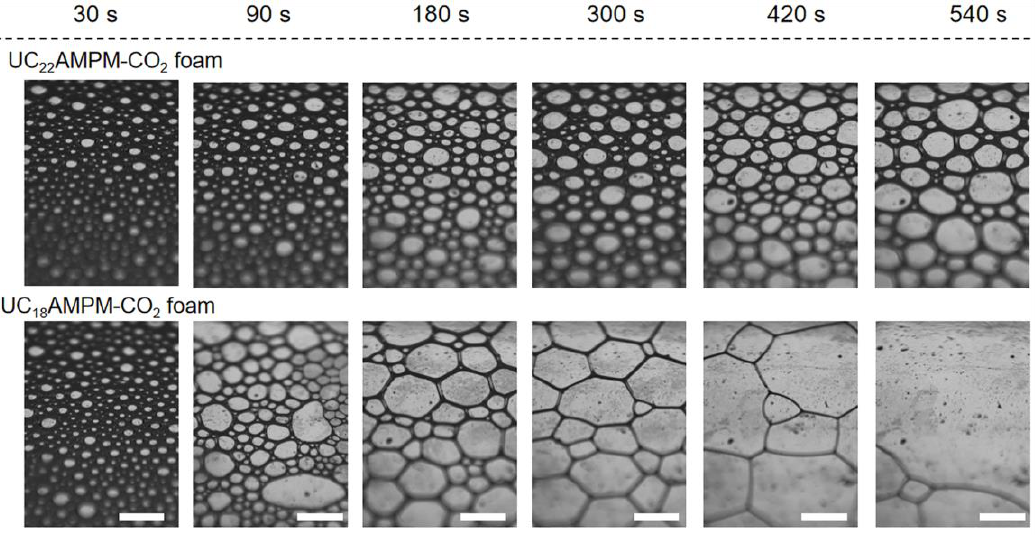
Figure 2. Comparison of morphology evolution of CO 2 aqueous foams made from 0.5% UC 22 AMPM and 0.5% UC 18 AMPM with time in atmospheric pressure at 35 °C.